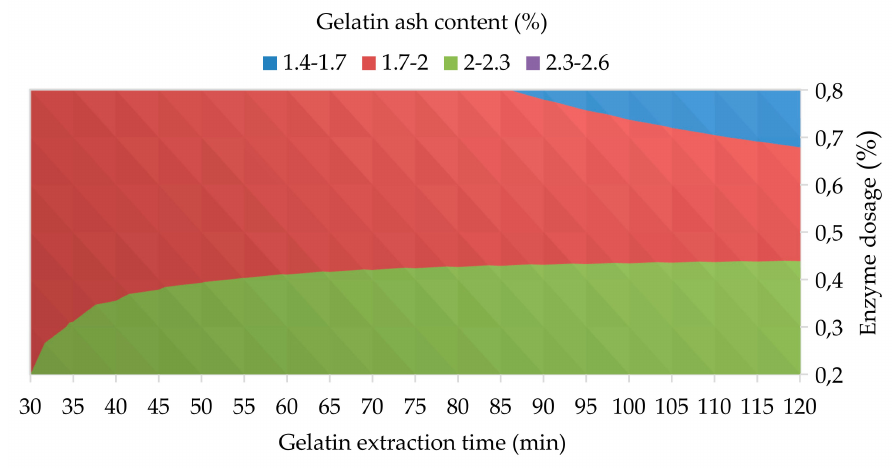
Figure 4. The influence of enzyme dosage and gelatin extraction time (at 48 h of enzyme processing time) on the gelatin ash